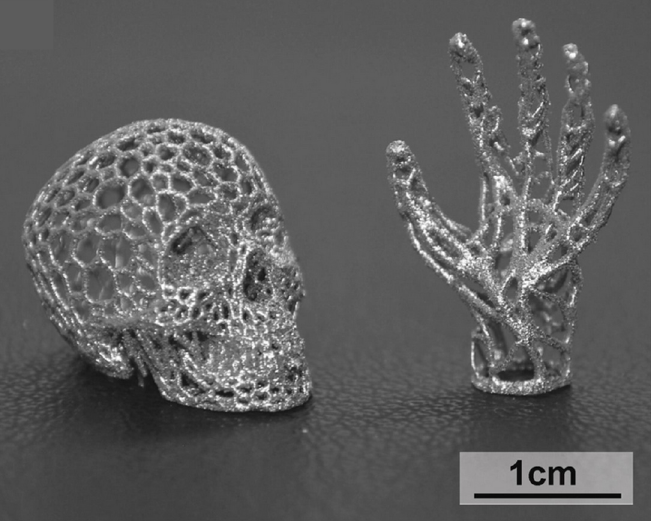
Figure 18. Ti-based BMG parts fabricated via LPBF. Modified from [39], with permission from Elsevier, 2021. Elsevier,